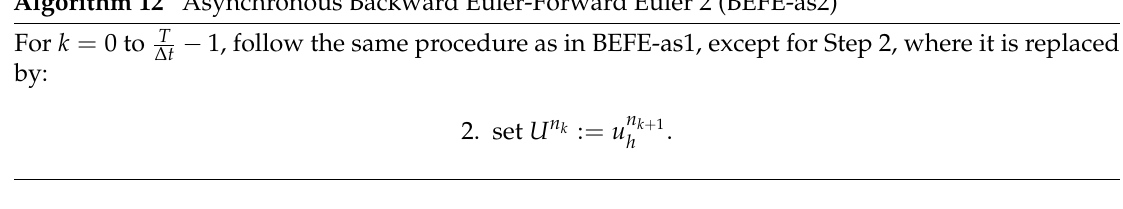
Algorithm 12 Asynchronous Backward Euler-Forward Euler 2